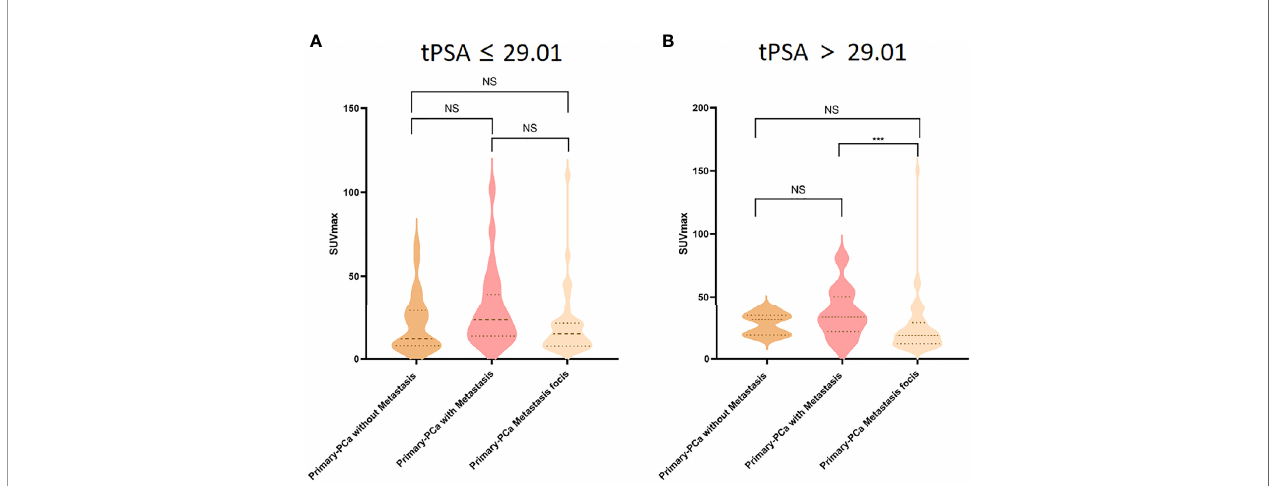
FIGURE 5 | Comparison of 18 F-PSMA-1007 SUVmax uptake in primary prostate tissue without metastasis (dark yellow violin box), primary prostate tissue with metastasis (pink violin box) and primary prostate cancer metastasis tissues (light yellow violin box) in tPSA ≤ 29.01 (A) and tPSA>29.01 (B) tPSA, total PSA; PCa, prostate cancer. ***P < 0.05, NS, No statistical difference.